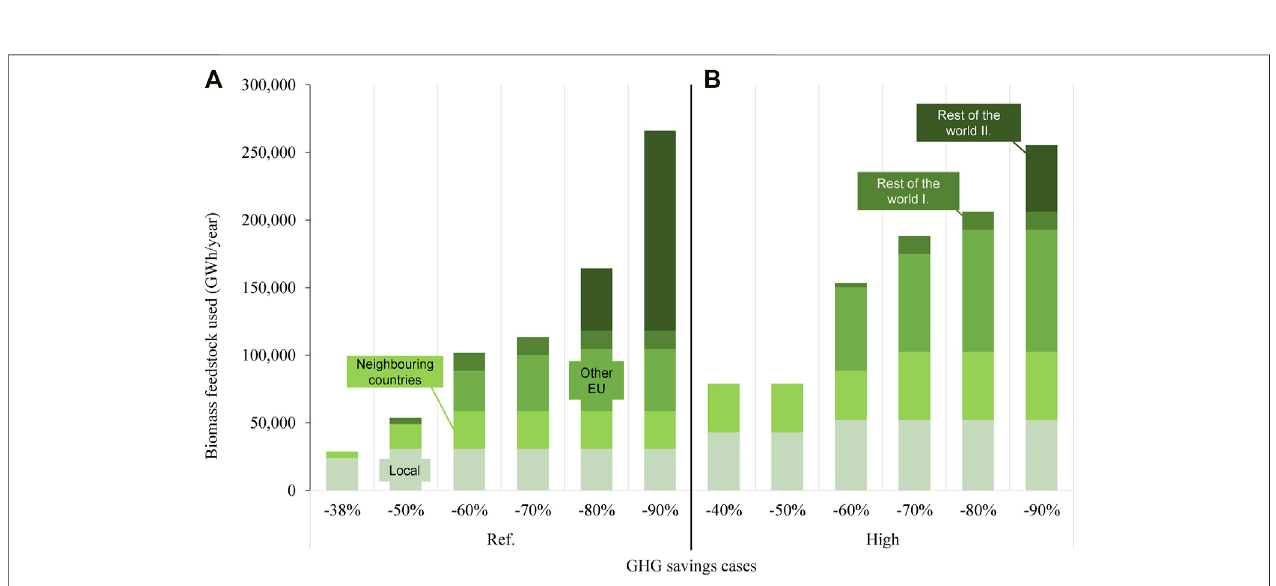
FIGURE 5 | Lignocellulosic biomass feedstock used divided by origin for the different GHG savings cases, for the reference (A) and high (B) potential scenarios.